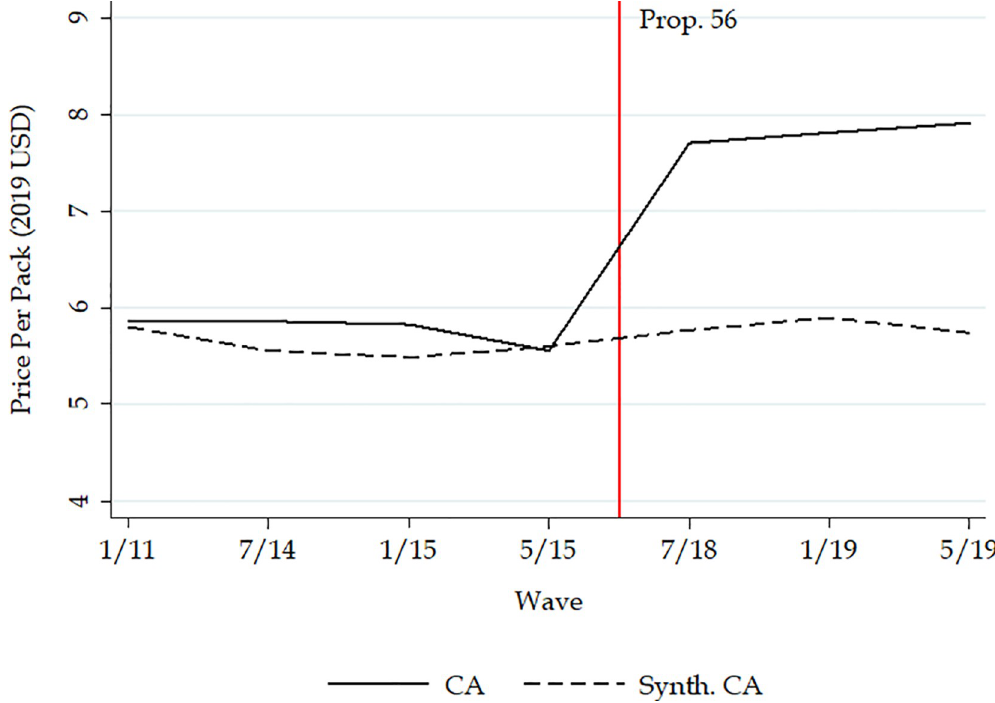
Fig 1. Comparison before and after the implementation of California Proposition 56 tobacco tax increase between California and synthetic control: Cigarette price ($2019).